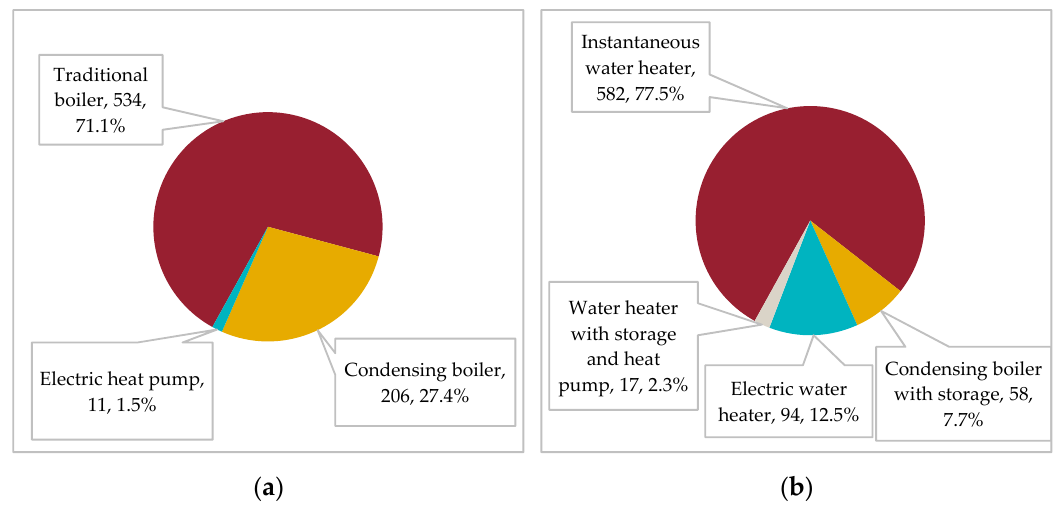
Figure 4. Heating system typologies: ( a ) inner Space heating; ( b ) DHW.